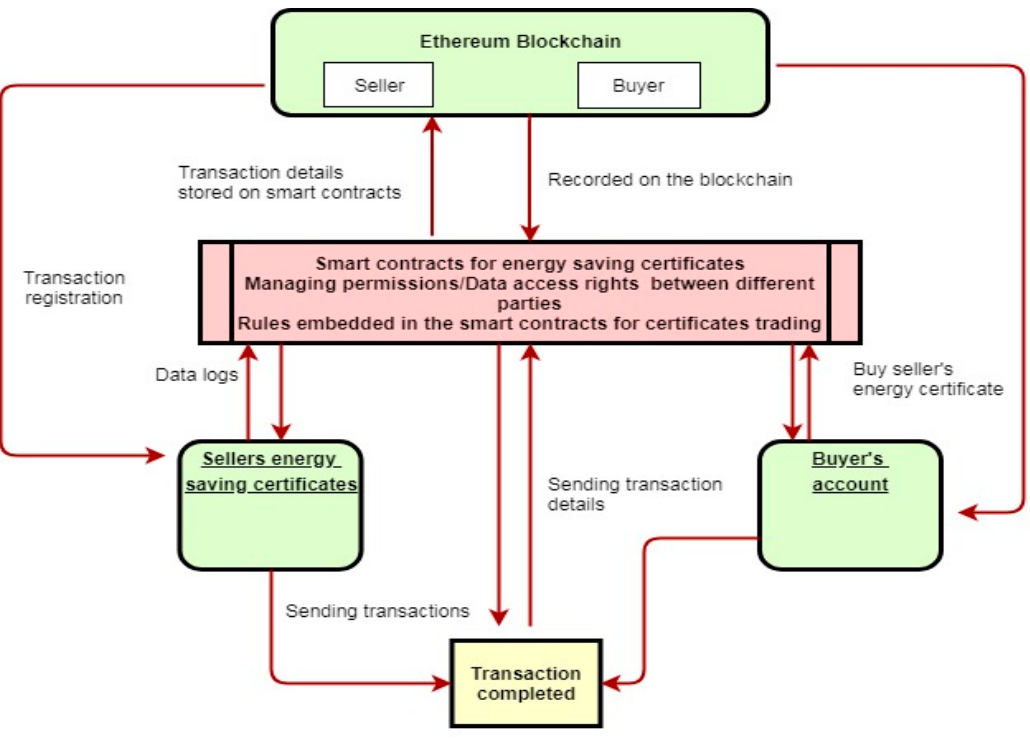
Energies 2019 , 12 , x FOR PEER REVIEW Figure 6. Blockchain-based smart contract system for energy saving certificates.